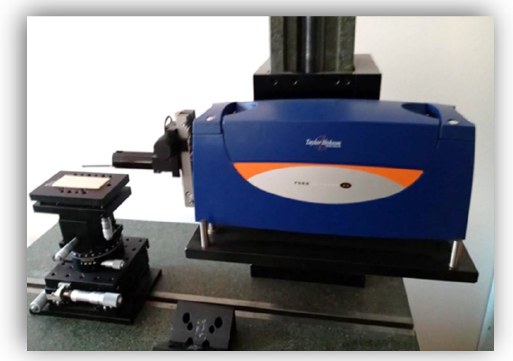
Figure 8. Roughness registration.